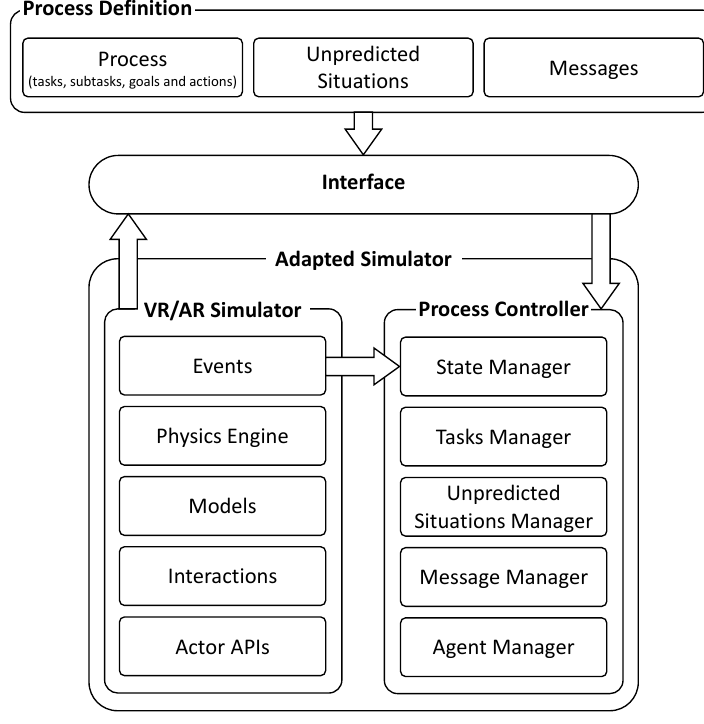
Figure 1. Framework scheme.